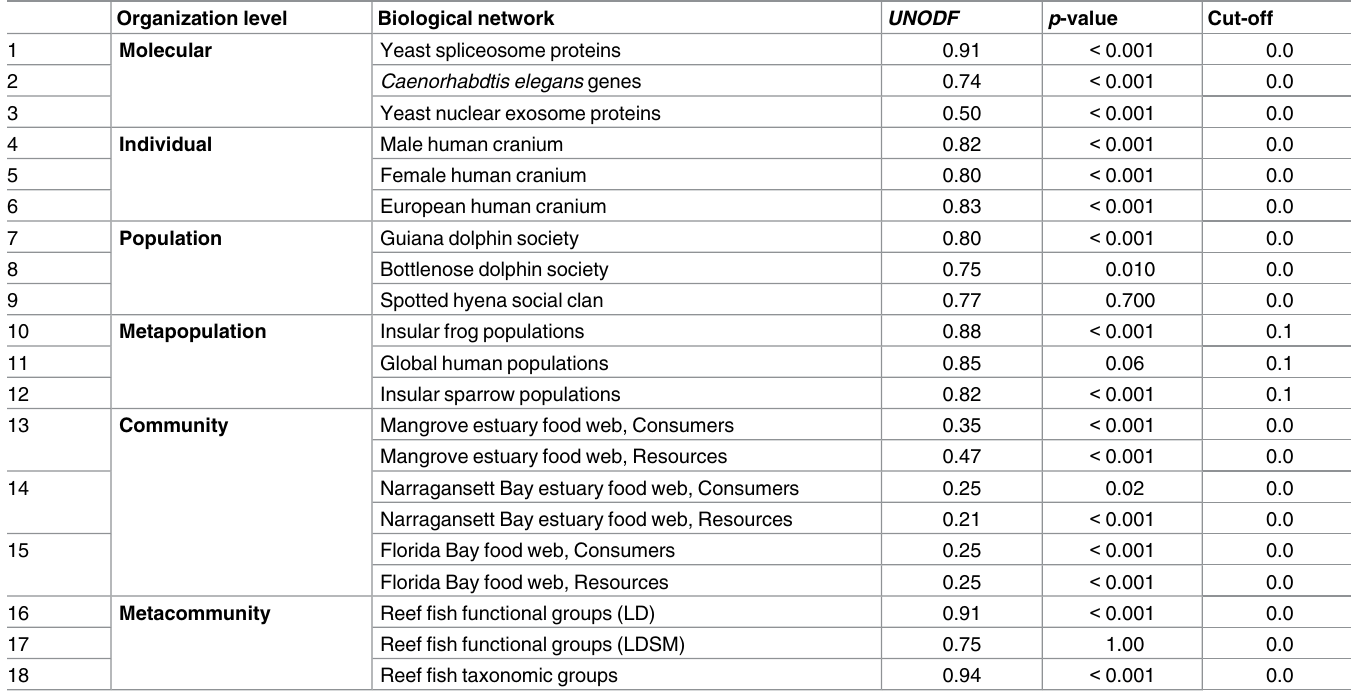
Table 1. Nestedness ( UNODF ) of 18 biological one-mode networks across 6 organization levels.